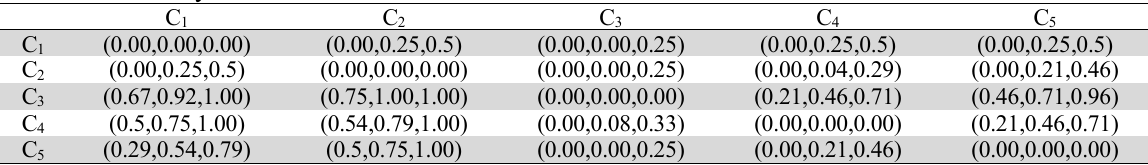
Initial-direct fuzzy matrix